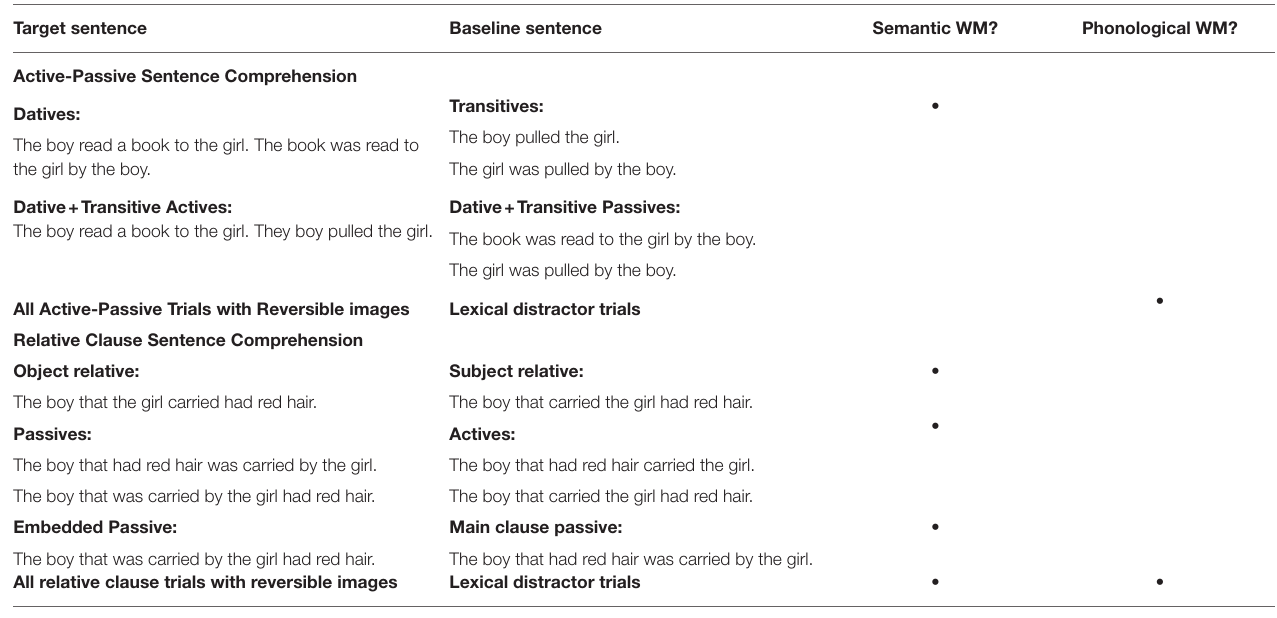
TABLE 9 | Summary of WM contributions to comprehension of target sentence when controlling for performance on baseline